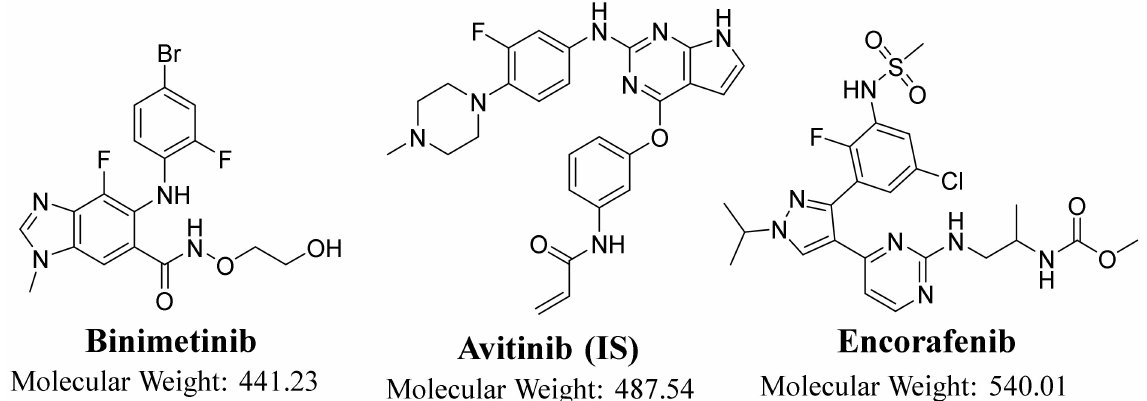
Figure 1. Chemical structures of binimetinib (BNB), avitinib (AVB), and encorafenib